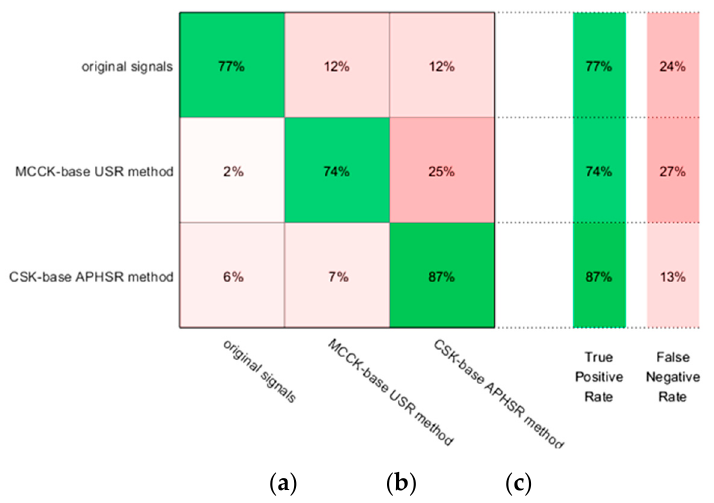
Figure 13. Recognition rates of inner ring: ( a ) original signals, and signals processed by ( b ) CSKMCCK-based USR method and ( c ) CSK-based APHSR method.